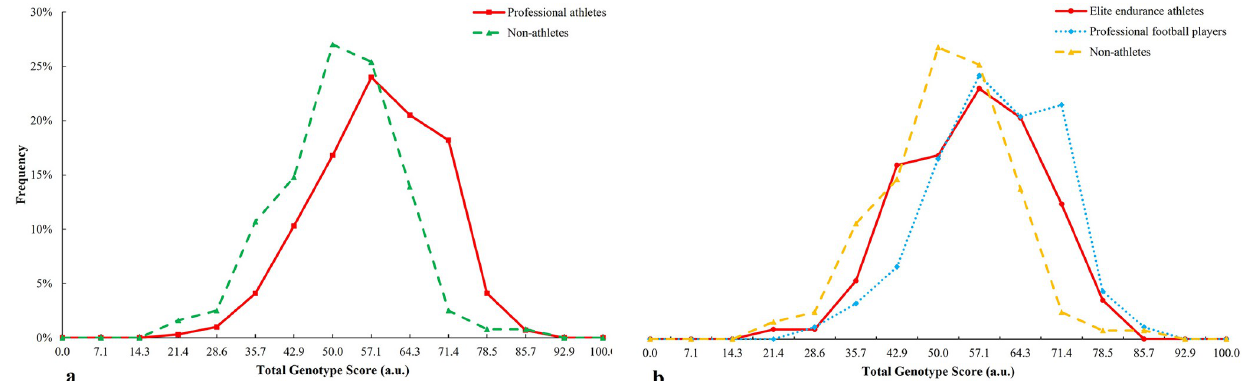
Fig 7. TGS distribution for muscle injuries genes in a) professional athletes and non-athlete subjects and b) endurance athletes and football players with regard to non-athlete subjects.